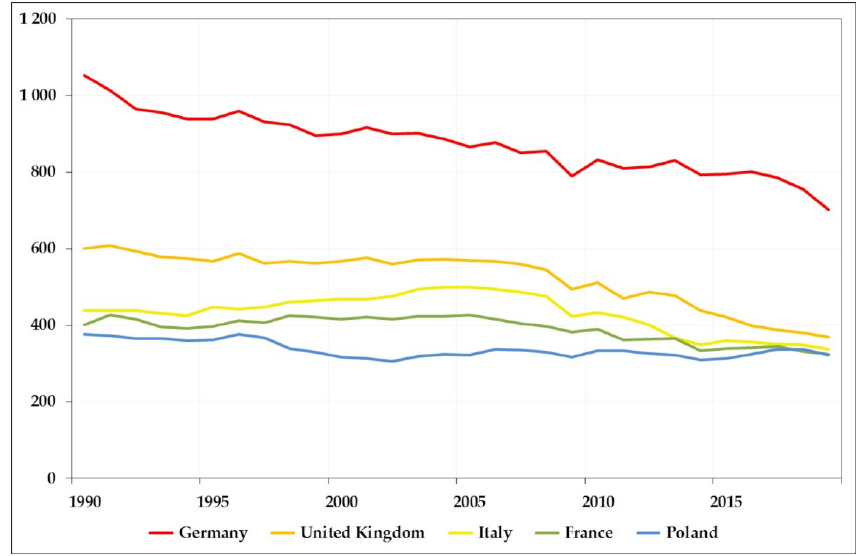
Figure 1. EU countries with the highest level of CO 2 emissions (in Mt) [5].